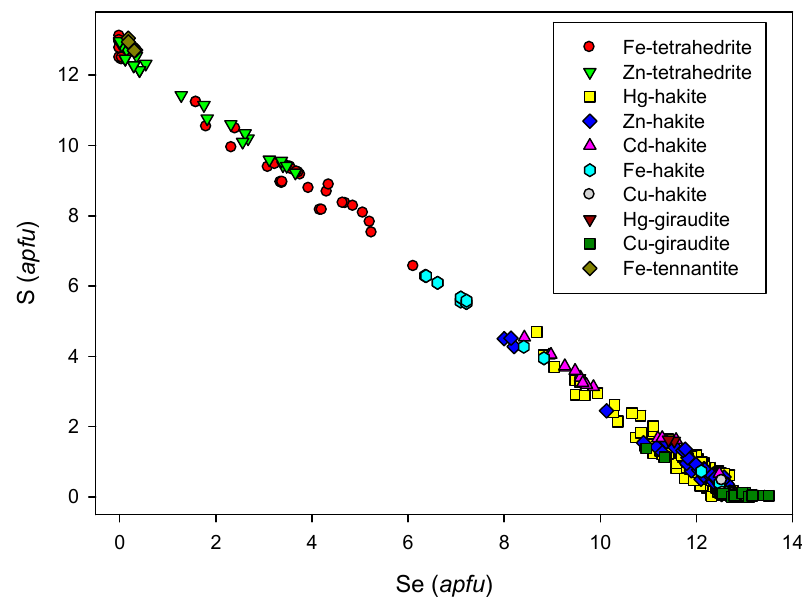
Figure 60. Se vs. S ( apfu ) graph for tetrahedrite group of minerals from P ř íbram.